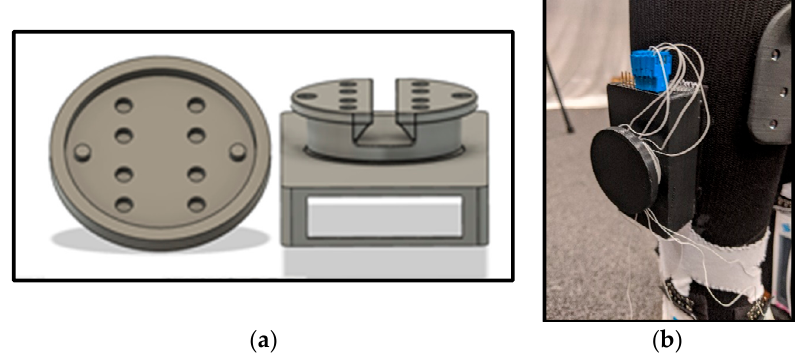
Figure 16. Wire management system. ( a ) CAD model version, ( b ) 3D printed version.